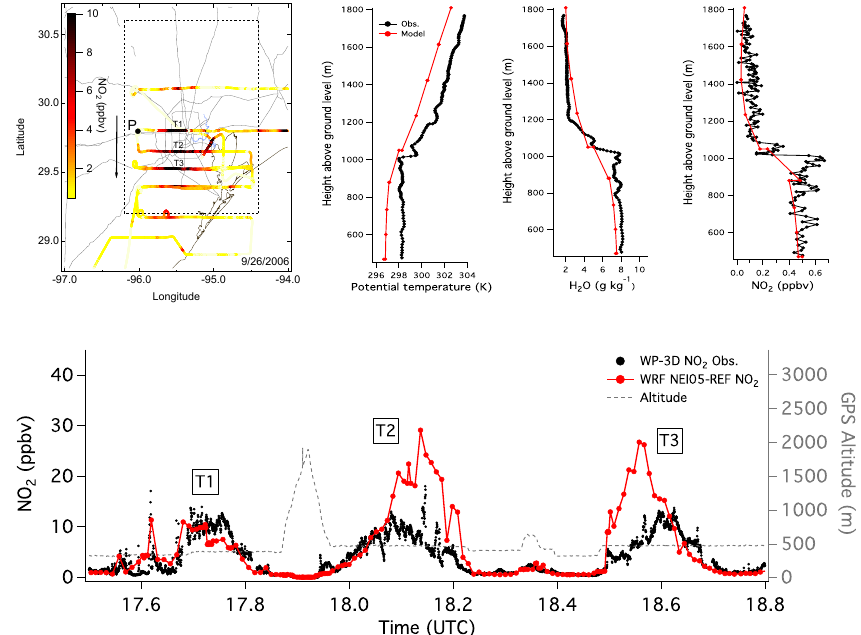
Figure 8. Map (top left) of the flight tracks on 26 September 2006 capturing Houston urban, industrial, and in-port shipping plumes. The WP-3D NO 2 mixing ratio is color coded over the flight paths. Arrow denotes a flight path in north-south direction. A box with a dashed line on the map is the Houston-Galveston region used for the satellite-model comparison (Fig. 1 and Table 4). T1–T3 represent transects 1–3. Vertical profiles of potential temperature, water vapor mixing ratio, and NO 2 measured at a point “P” on the map are shown (top right). The WRF-Chem model and WP-3D NO 2 for segments of the flight are compared (bottom).